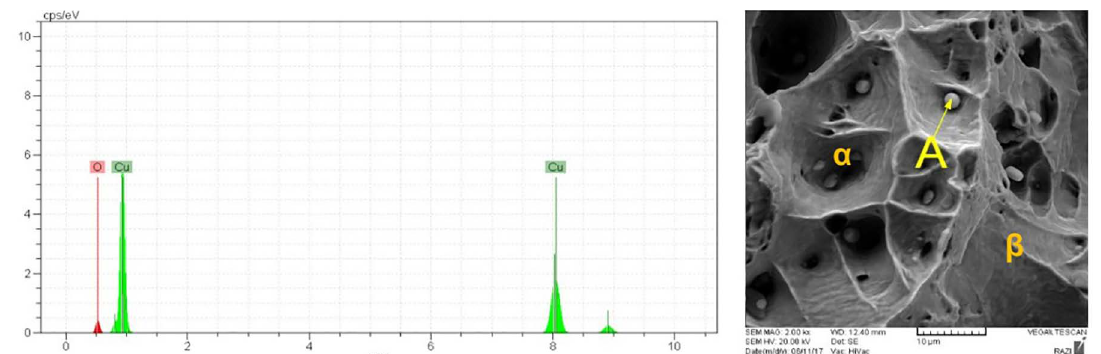
Figure 13. EDS analysis of fractured surface for 450 rpm- 16 mm/min